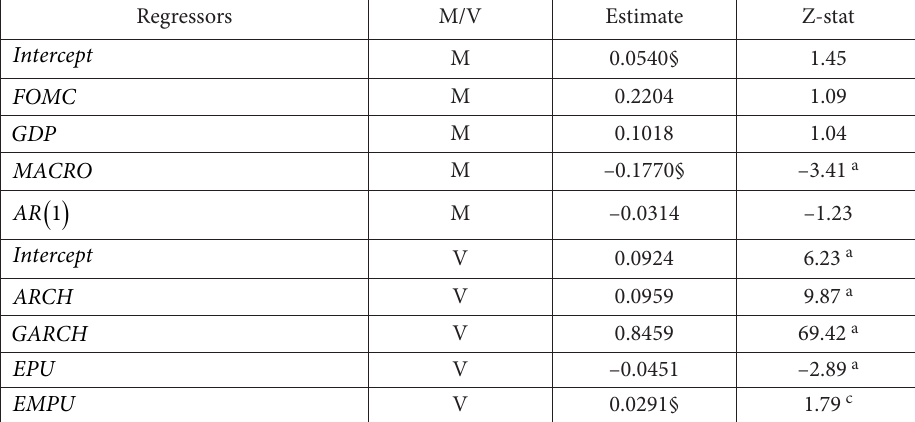
Table 12. Economic policy uncertainty and corn implied volatility index